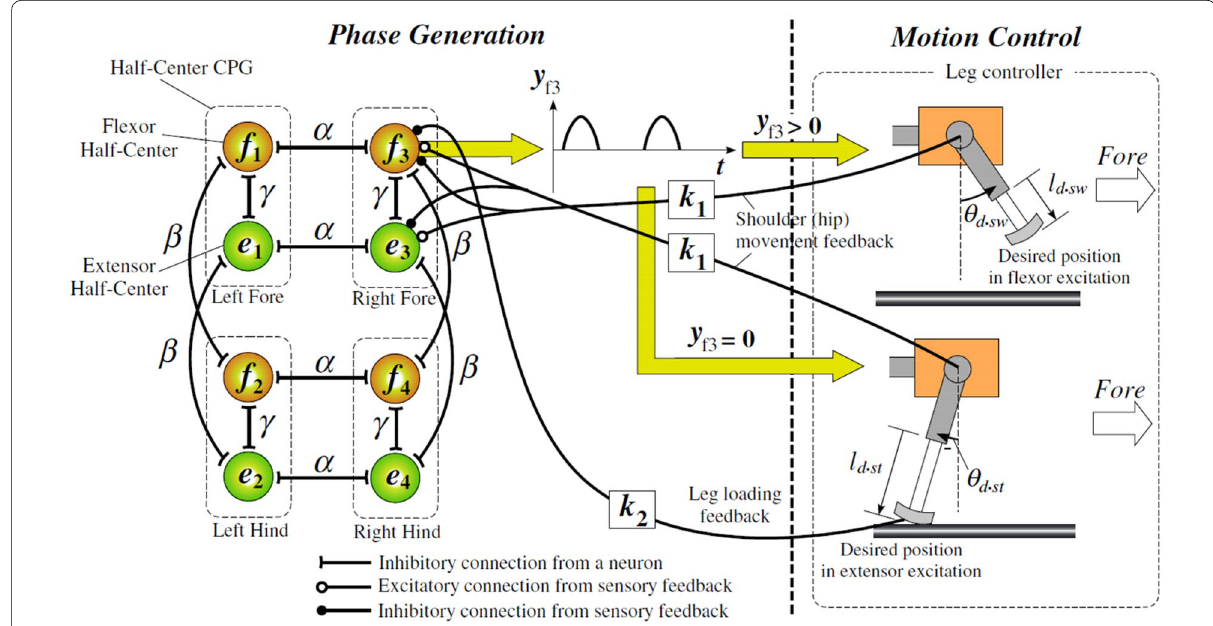
Figure 19 Example configuration of the CPG model